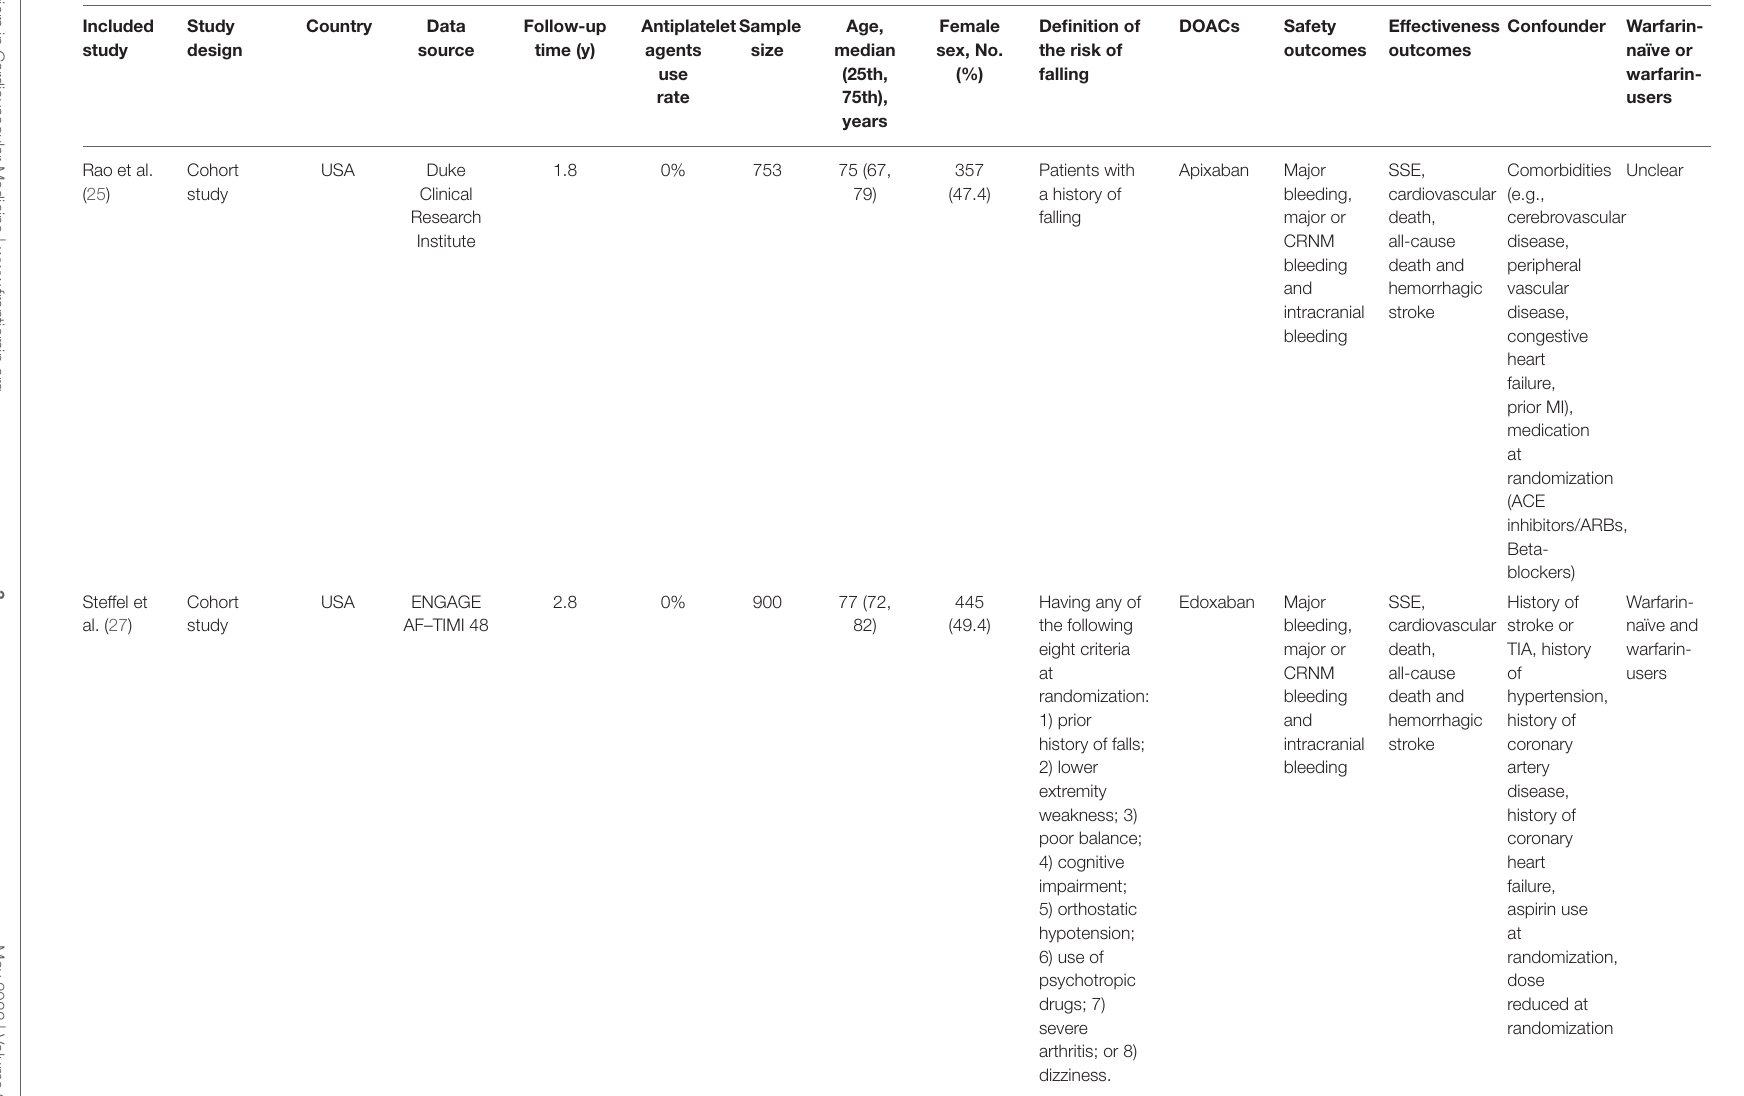
TABLE 1 | Baseline characteristics of included